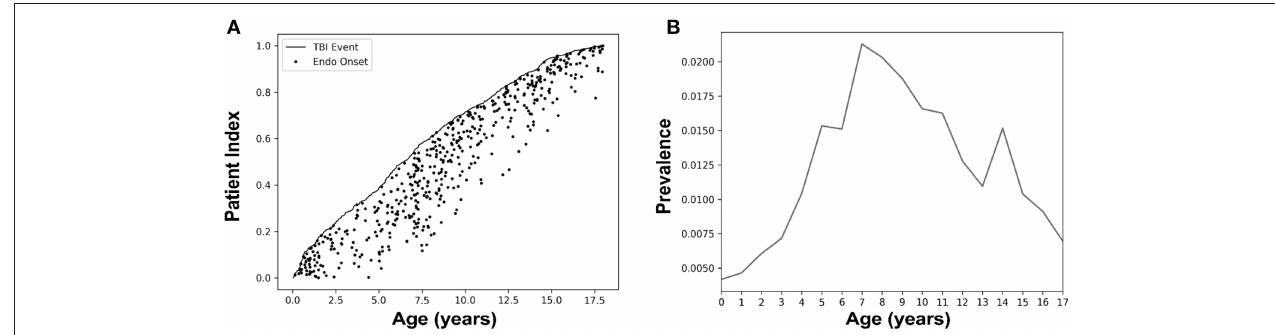
FIGURE 1 | Pediatric patients with a traumatic brain injury (TBI) who were diagnosed with a hypothalamic-pituitary disorder showed the highest prevalence in ages 7–11. (A) Patients ( n = 498) with a TBI and subsequent endocrine diagnosis were indexed by age. Here, we sorted all patients of our group of interest by age with patient index referring to the fraction of the total. The black line represents the age of each patient when they were diagnosed with a TBI, and the dot tracking along the x-axis from the line indicates the subsequent onset of their first endocrine diagnosis. (B) Prevalence of an endocrine diagnosis after a TBI stratified by age at the endocrine diagnosis. Here, prevalence was calculated as the number of TBI patients with an endocrine diagnosis divided by those TBI patients without an endocrine. Children aged 7–11 years had the highest prevalence of an endocrine disorder diagnosis after a TBI diagnosis compared to other age